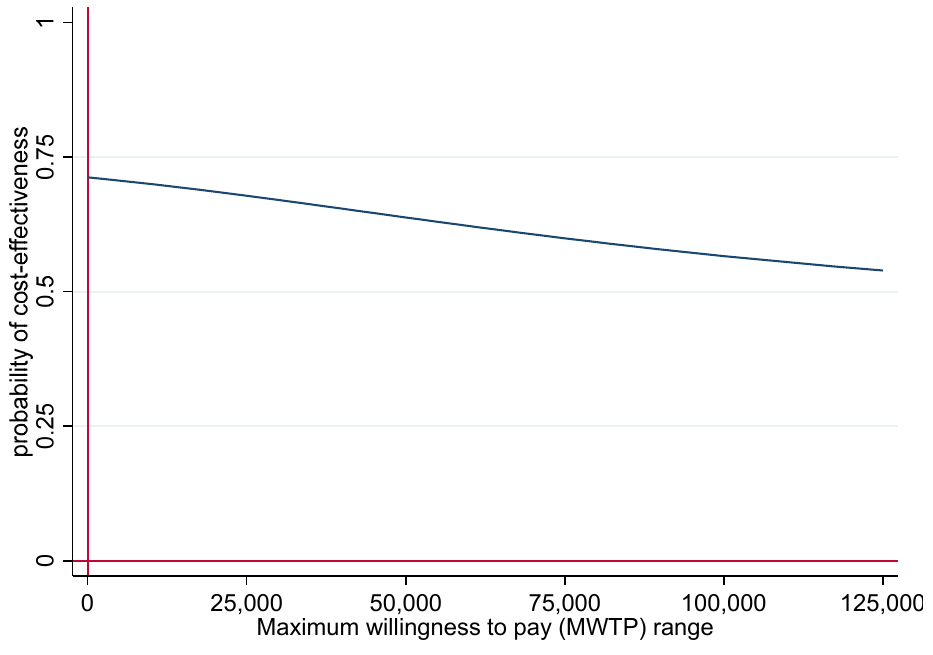
Figure 3. Cost-effectiveness acceptability curve indicating the probability of cost-effectiveness across the maximum willingness to pay range.